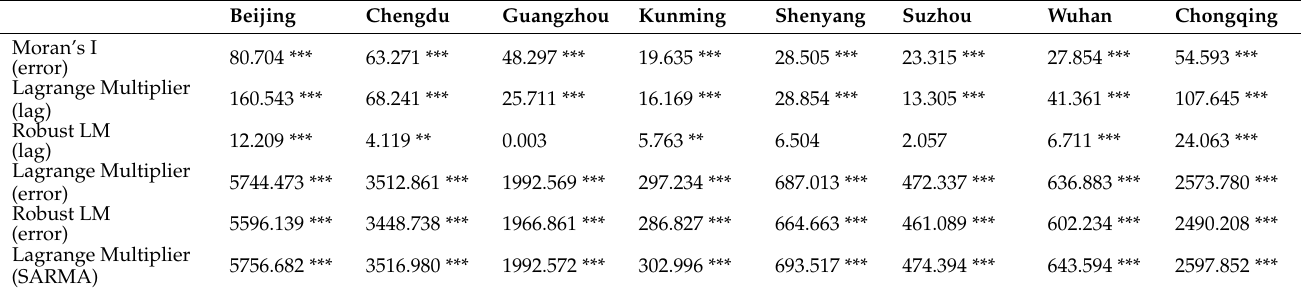
Table A13. LM tests for Model I.